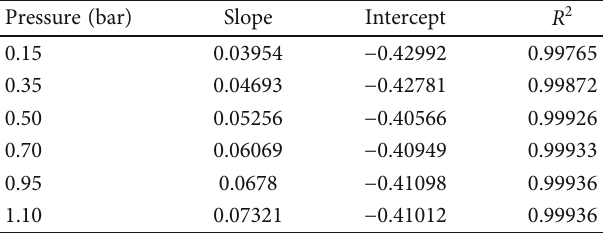
Table 3: Kinetic parameters of linear fi tting of fi lm di ff usion